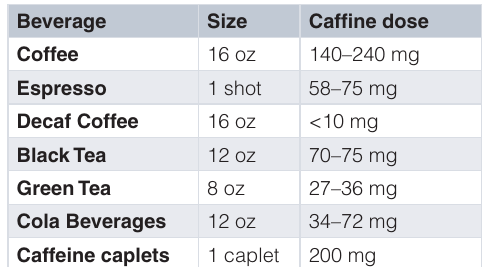
Table 2. Estimated caffeine doses of commonly ingested caffeinated substances 59–61